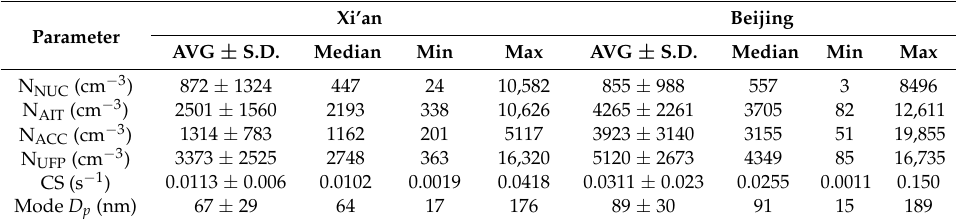
Table 1. The arithmetic average, standard deviation (S.D.), median, minimum and maximum of particle number concentrations in different size ranges, CS, and Mode D p at the two suburban sites of Xi’an and Beijing based on hourly averaged